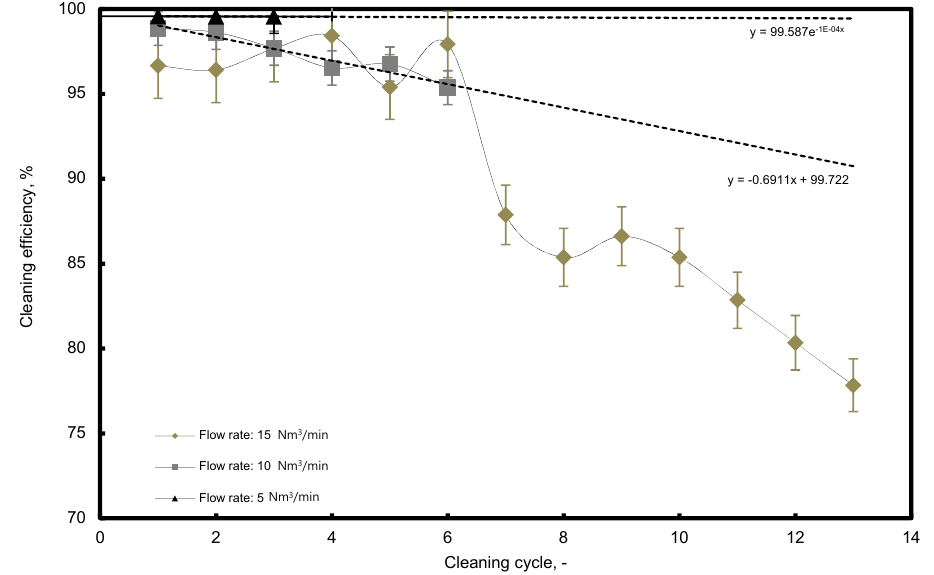
Figure 7. Cleaning efficiency results with flow rate variable.